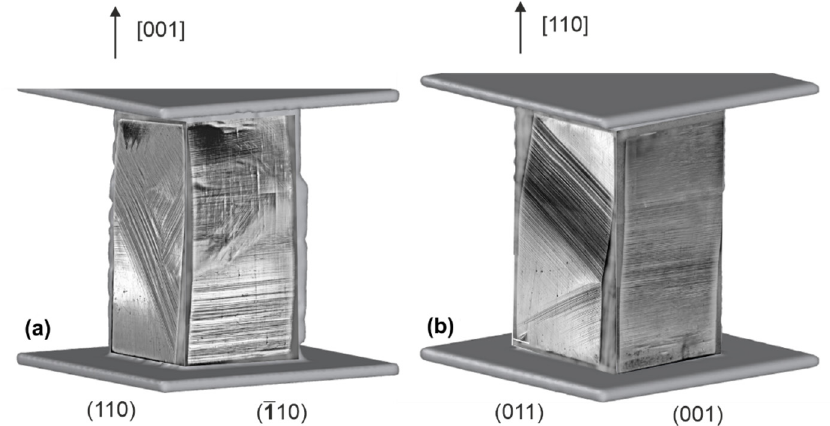
Figure 4. Experimentally observed single crystals deformation relief, ε = 7% (panels ( a , b ) differ in the direction of the deformation axis and the orientation of the lateral faces, which are indicated in the sub ‐ pictures).